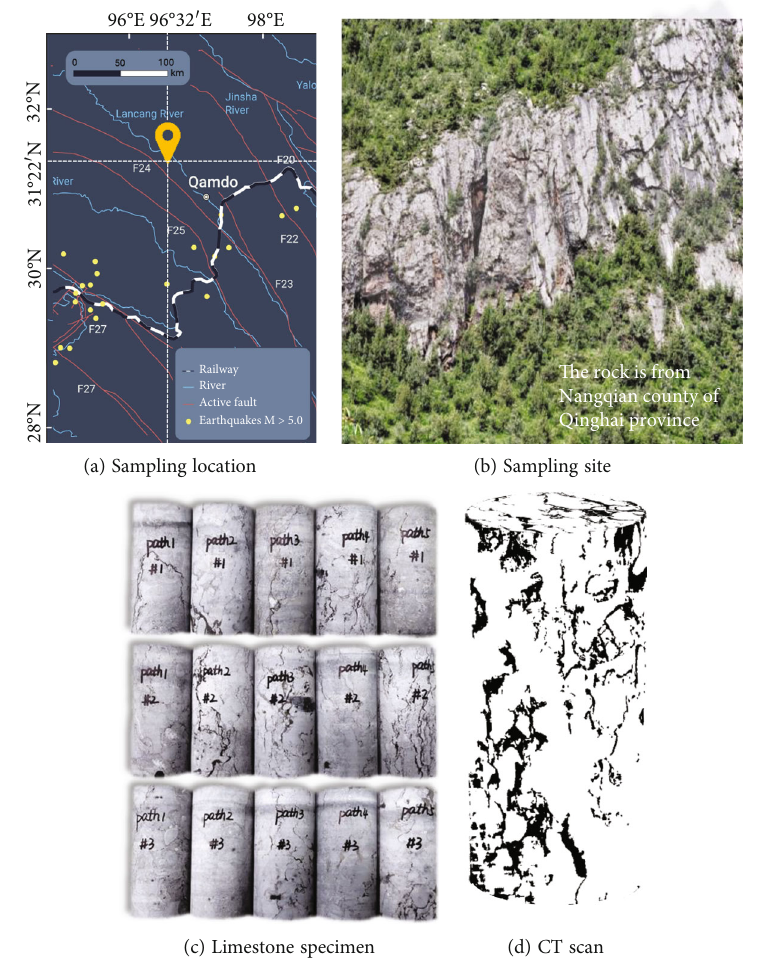
Figure 1: Sampling site and specimens.